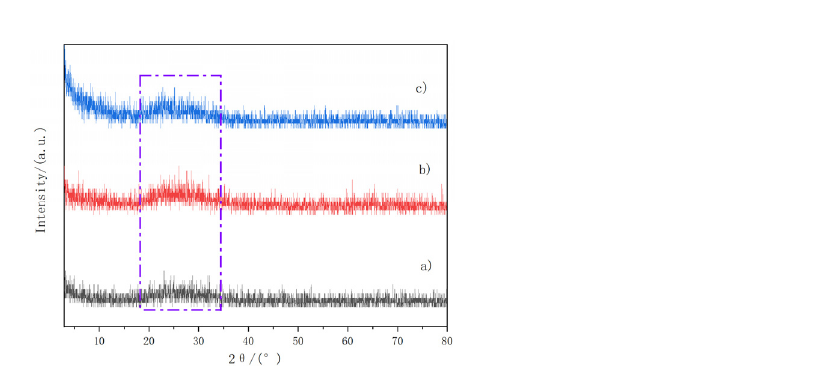
fibers; ( c ) coupling-modified fibers.